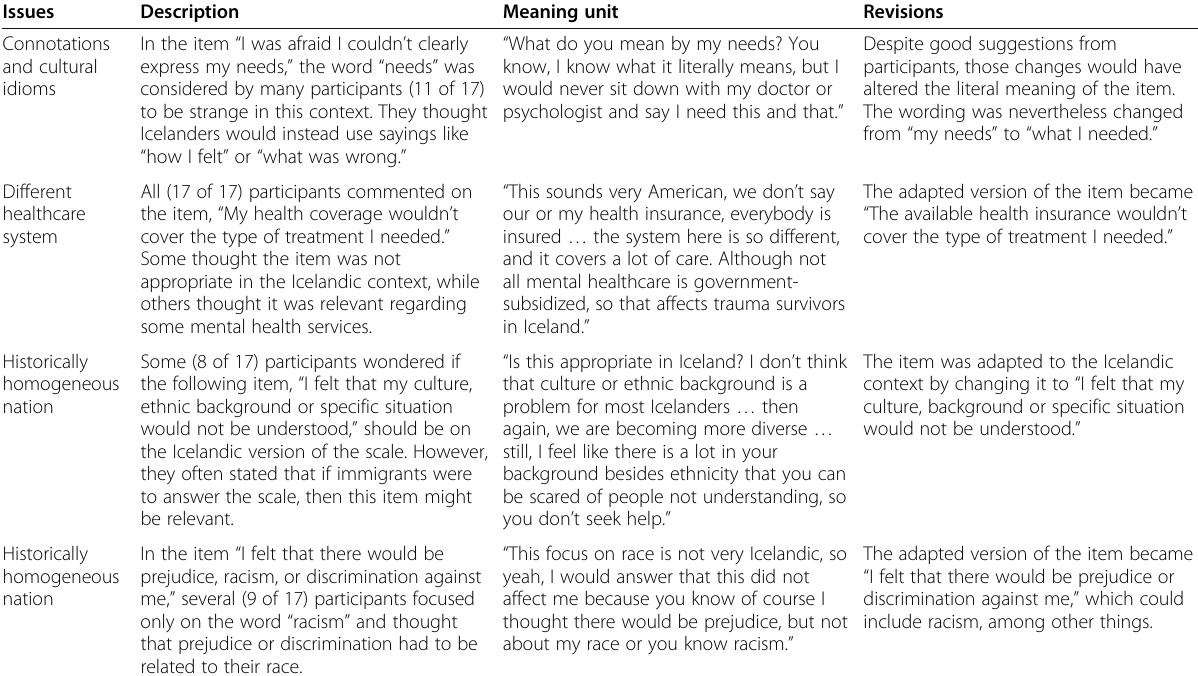
Table 6 Examples of cultural issues